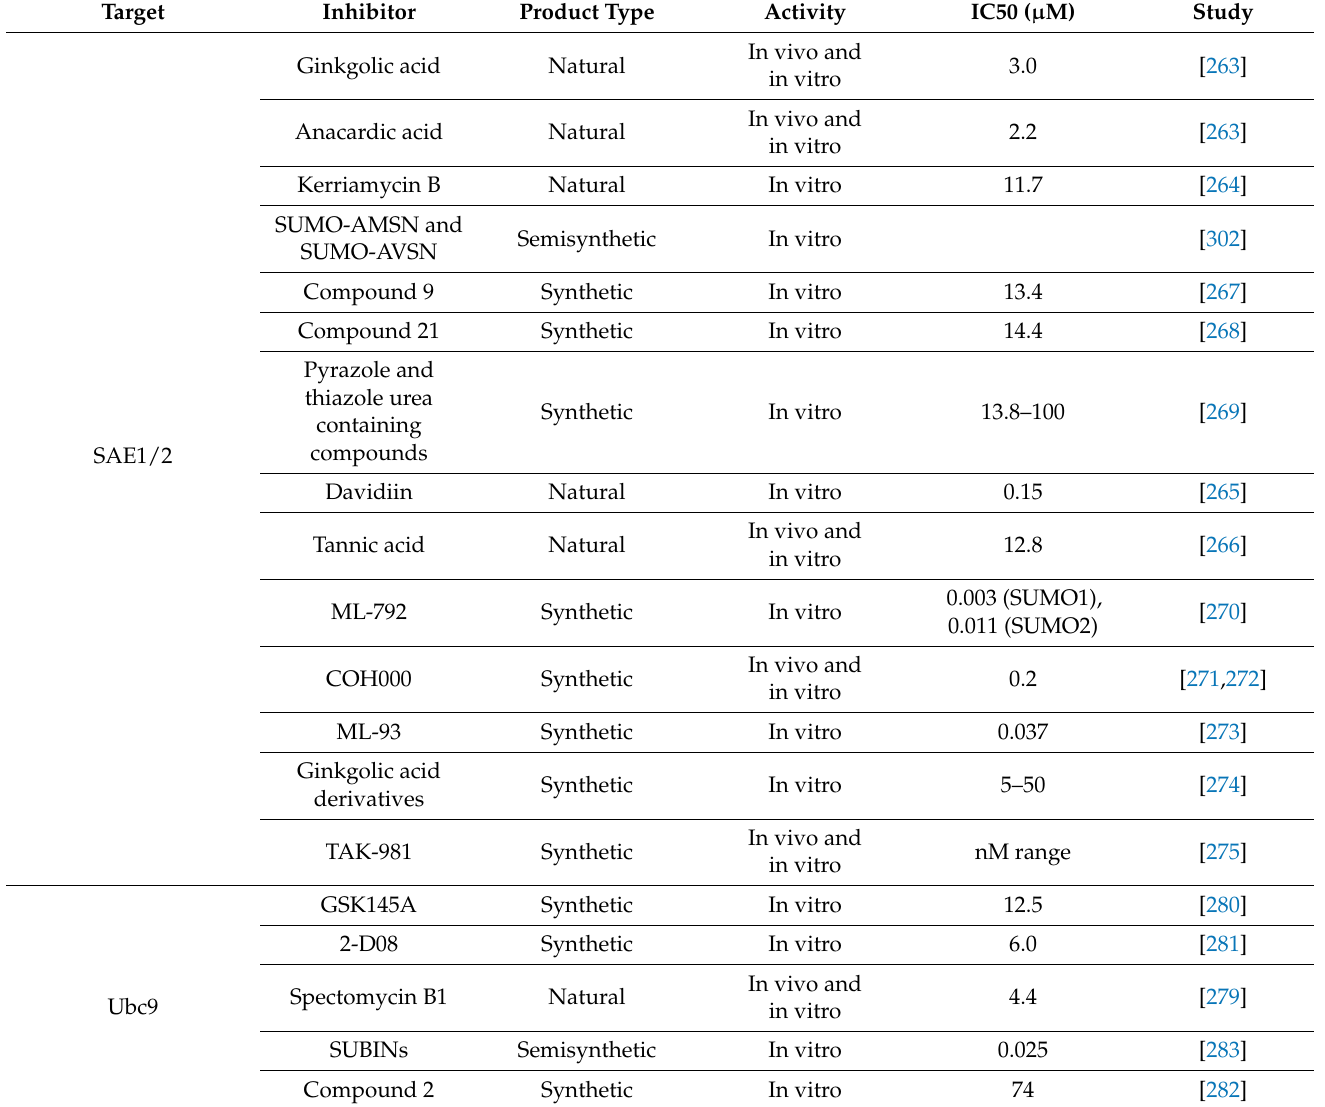
Table 2. Preclinical development of inhibitors targeting SUMO pathway. IC50 = half maximal inhibitory concentration of SUMOylation or deSUMOylation.